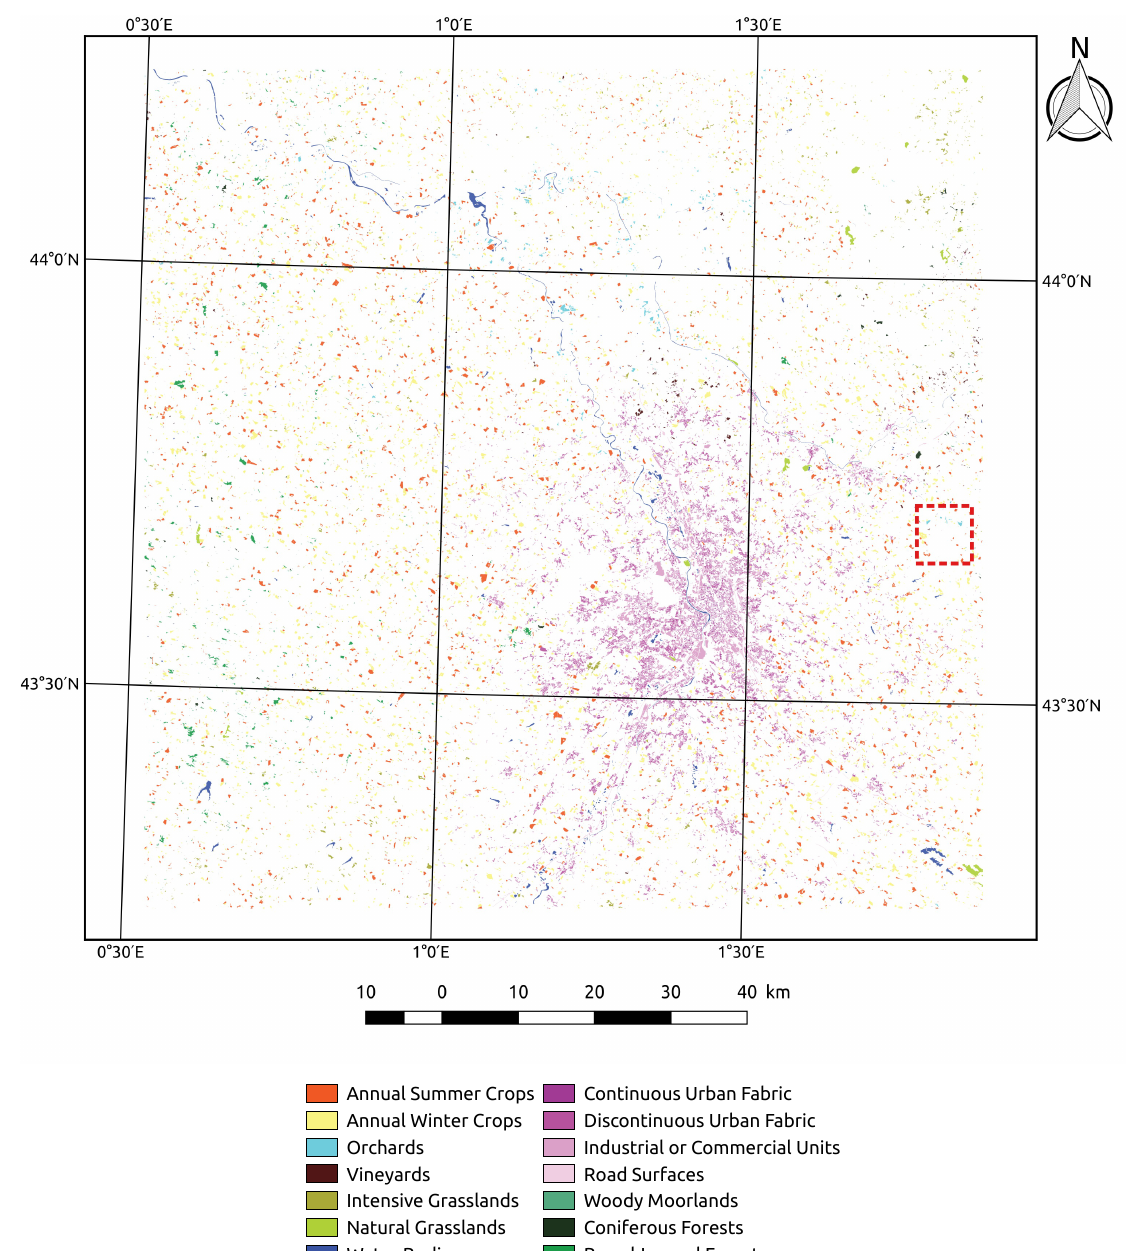
Figure 13. Reference polygons, later split into training and the validation